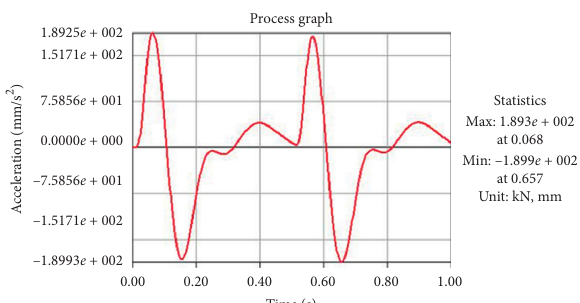
Figure 25: Section plan of the lattice diaphragm